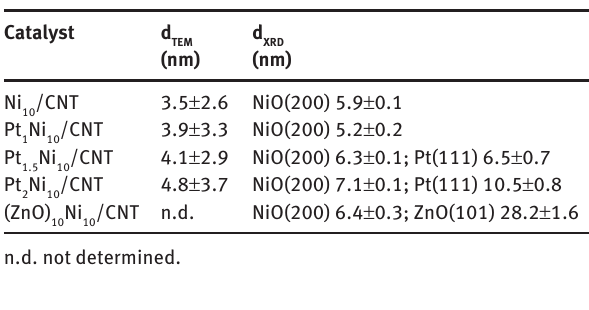
Table 3: The average metal particle sizes of carbon nanotube (CNT)- based catalysts by X-ray powder diffraction (XRD) and transmission electron microscopy (TEM).